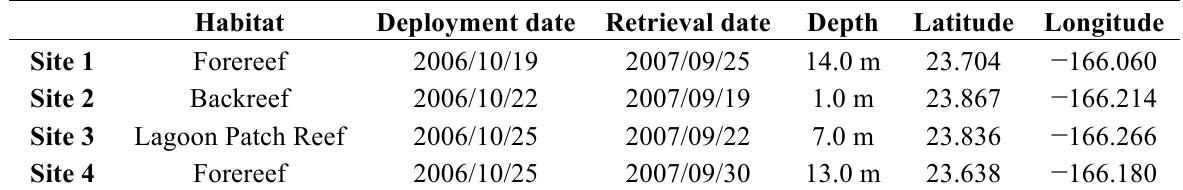
Table 1. Details of the four sampling sites on the French Frigate Shoals reef.